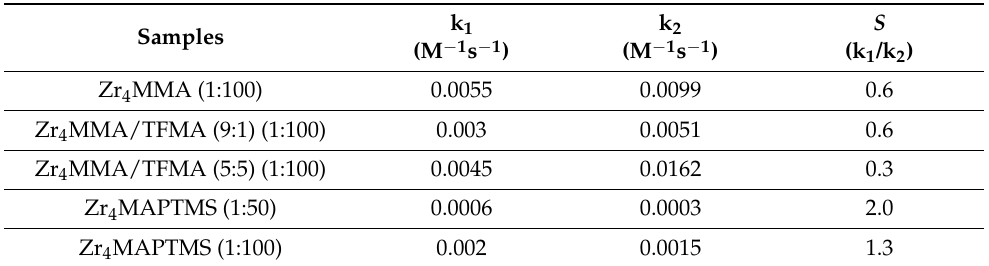
Table 5. Kinetic constants and selectivity parameters of Zr 4 MMA (1:100), Zr 4 MMA/TFMA